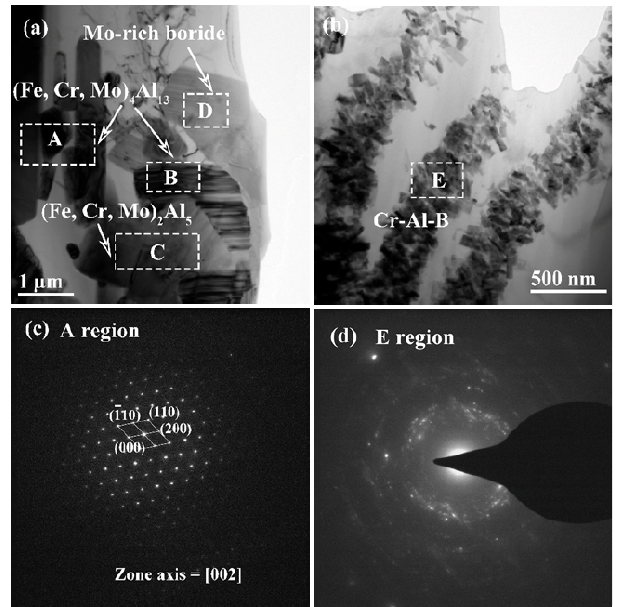
Figure 10. TEM images of the corrosion products of alloy M4 in molten aluminum for 8h: ( a , b ) Bright-field TEM micrographs and corresponding SADPs of corrosion products: ( c ) corresponding SADPs from (Fe, Cr, Mo)4Al13 reflected from [002], ( d ) corresponding SADPs from Cr-Al-B IMCs. Table 3. Chemical composition (in at.%) of the phases (in Figure 10a,b) in the corrosion products of M4 analyzed by TEM-EDS.